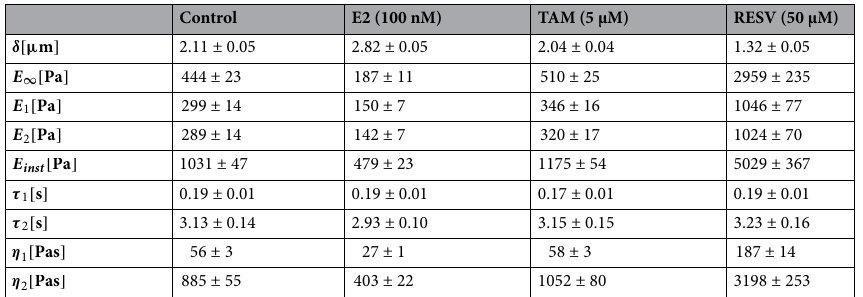
Table 1. Viscoelastic properties of the different groups of treated cells (control (CTL), estrogen (E2), tamoxifen (TAM) and resveratrol (RESV)) derived from the stress relaxation measurements. The values show mean value ± standard error of mean. δ is indentation, E ∞ the equilibrium modulus, E 1 and E 2 the moduli of the springs in Maxwell arms, E inst the instantaneous modulus, τ 1 and τ 2 the relaxation times of the dashpots and the viscosities are η 1 and η 2 . N is 412 for CTL, 224 for E2, 229 for TAM and 171 for